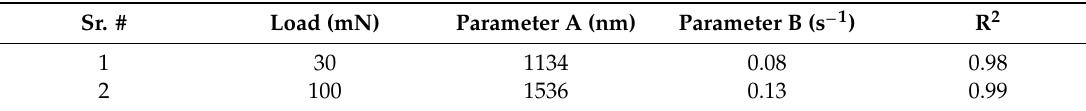
Table 1. Values of fitting parameters of Equation (1) for